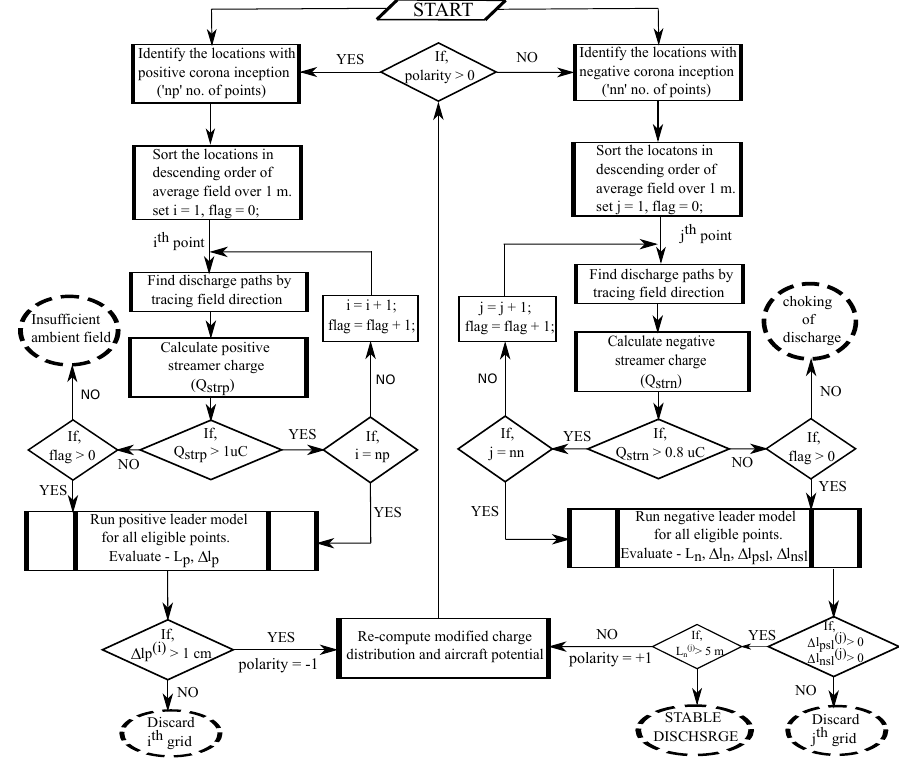
Figure 8. Detailed flowchart for the proposed